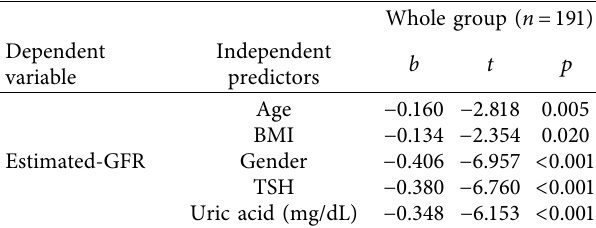
Table 4: Multiple linear regression model with estimated-GFR (log 10